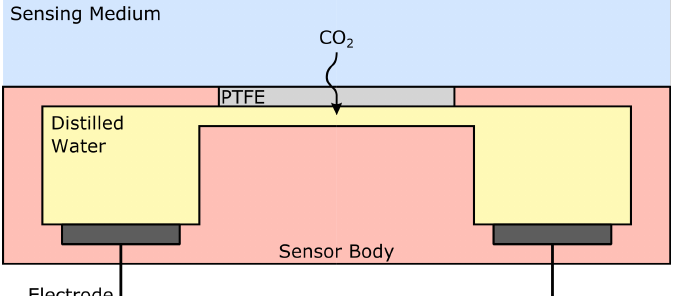
Figure 4. Outline of a static conductometric cell. CO 2 diffuses into distilled water, modifying the concentration of H 3 O + , HO − and HCO − and thus the conductivity of the solution, which may be 3 measured using alternative current to avoid polarisation by mean of two